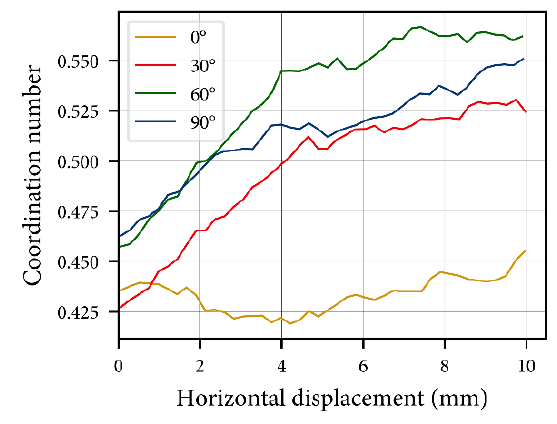
Figure 13. Evolution of coordination number for sand–fiber contact.